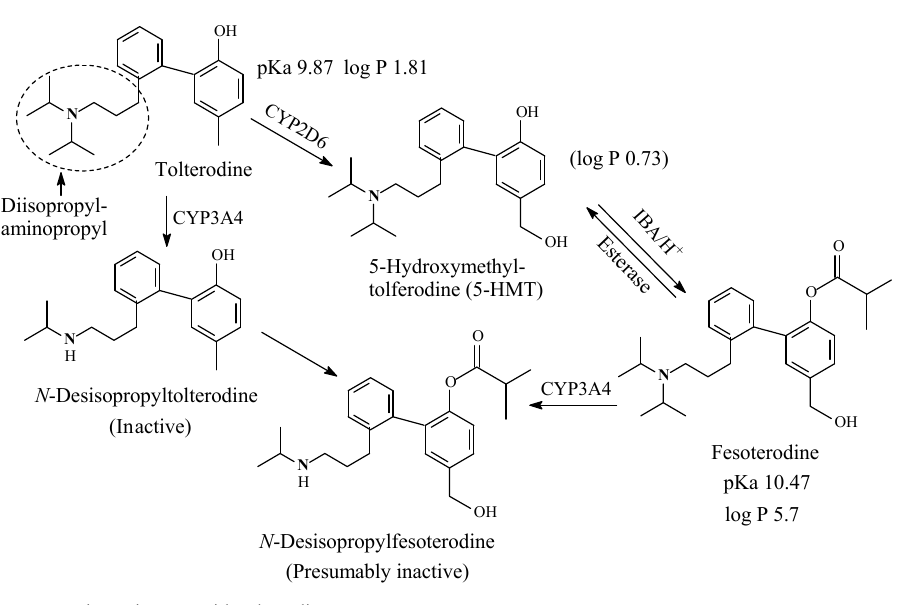
Figure 34. Metabolic pathways of tolterodine and fesoterodine.